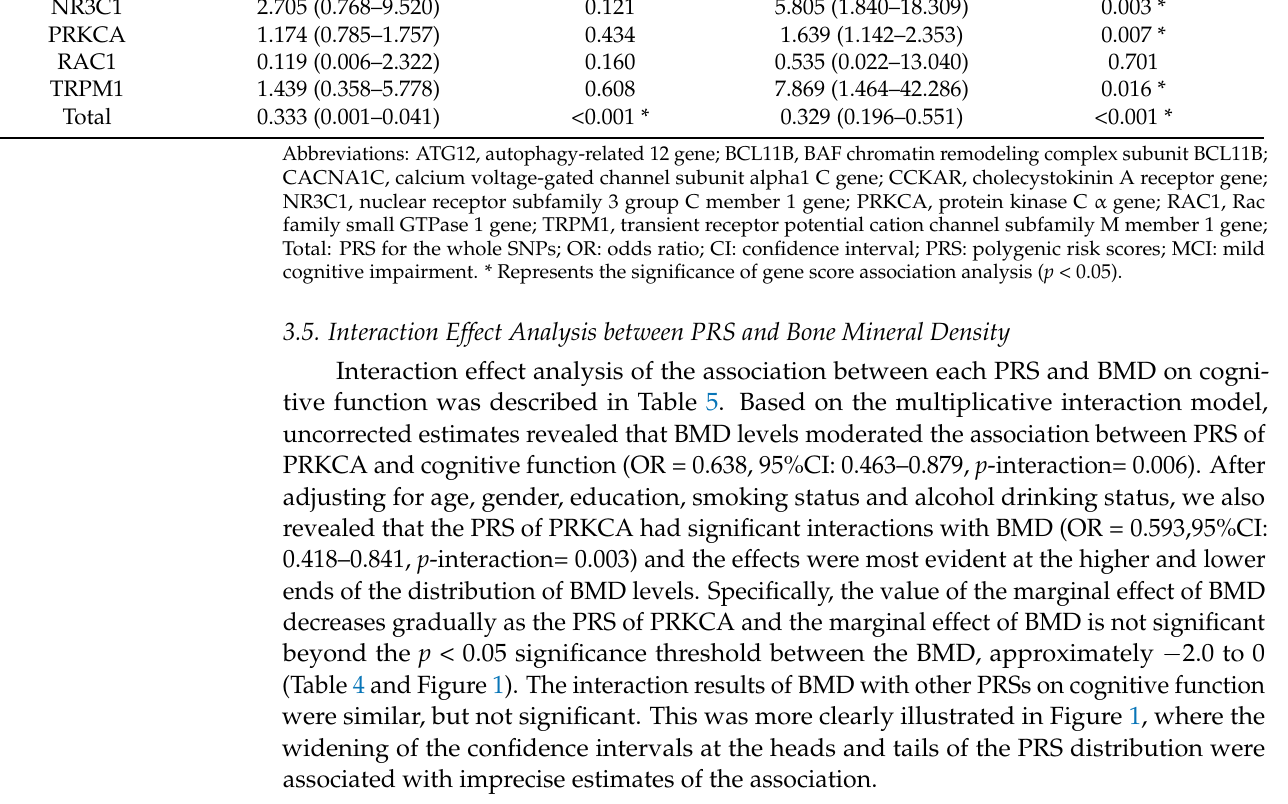
Table 5. Interaction effect analysis of the association between PRS and bone mineral density on